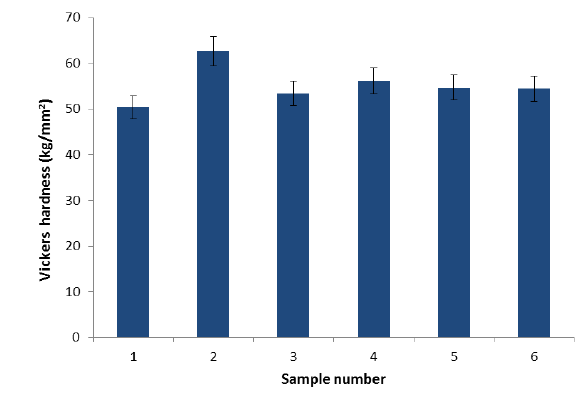
Figure 11: Impact strength for all composites.